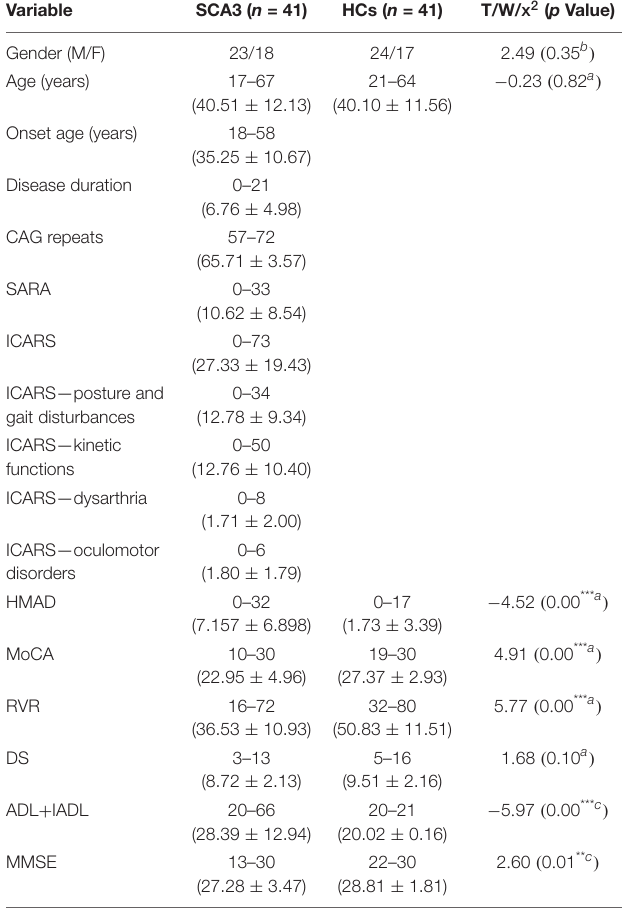
TABLE 1 | Demographic, clinical, and cognitive